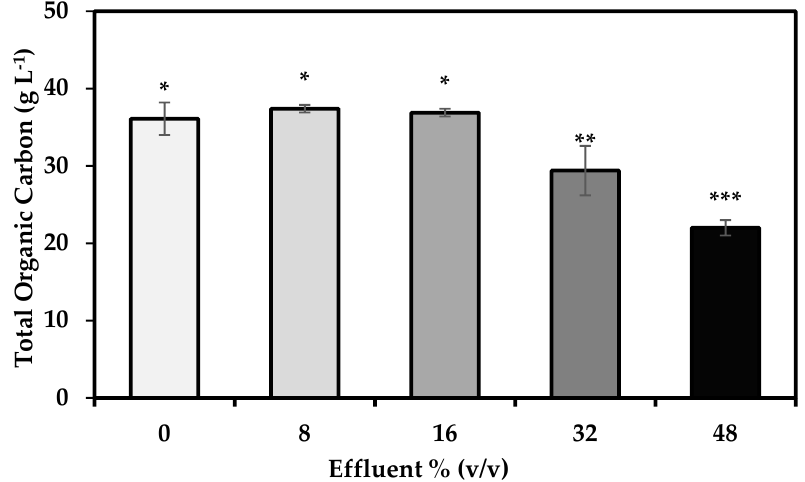
Figure 3. Effect of effluent digestate at varying concentrations (0–48%) with the same carbon and nitrogen concentration of the medium without the addition of micronutrients on total organic carbon assimilation of S. limacinum . Values are represented as mean ± standard deviation of triplicates, whereas asterisks indicate statistical differences analyzed at a level of p < 0.05.